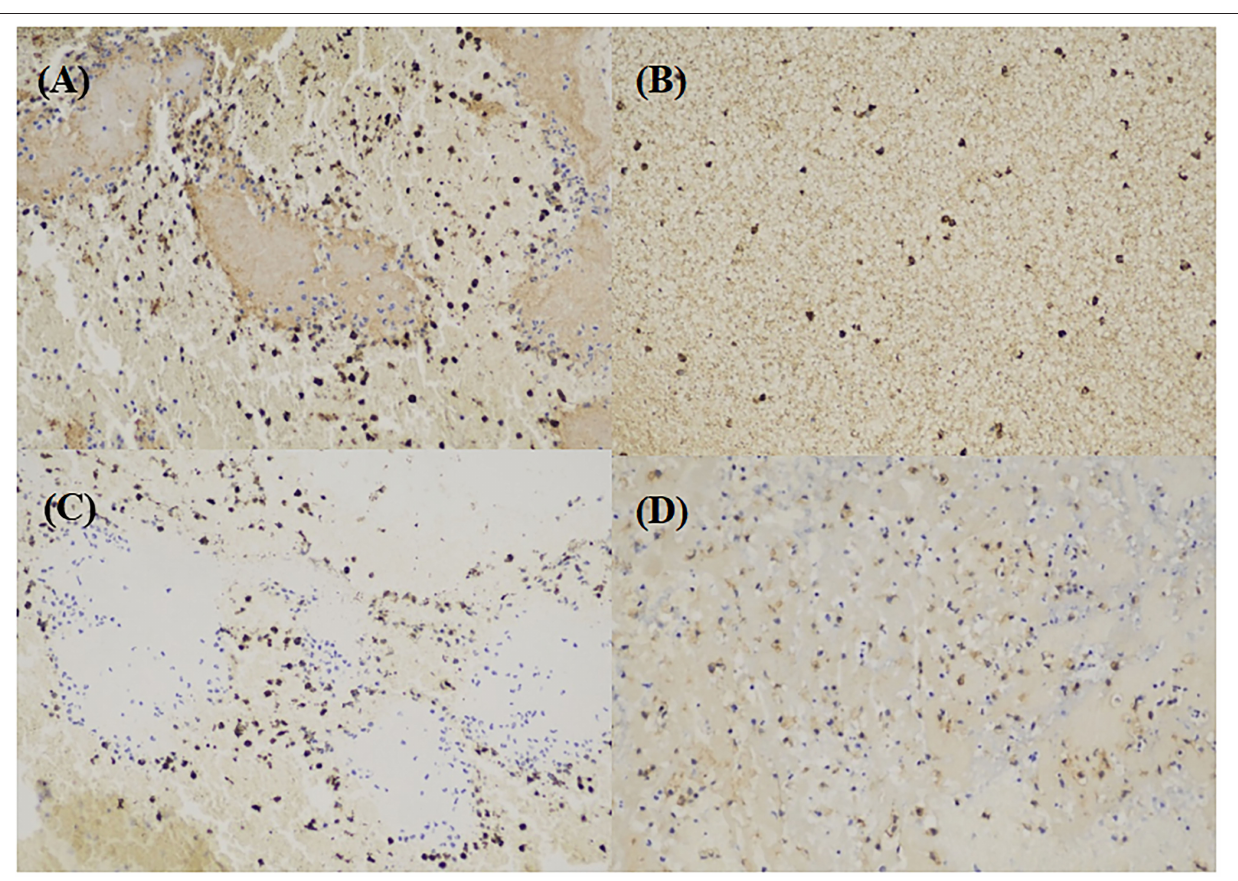
FIGURE 1 | Immunohistochemistry (IHC) imaging. (A) actin (brown) in large-artery atherosclerosis (LAA) stroke subtype. (B) CD3 (brown) in LAA stroke subtype. (C) CD20 cells (brown) in LAA stroke subtype. (D) CD105 cells (brown) in LAA stroke